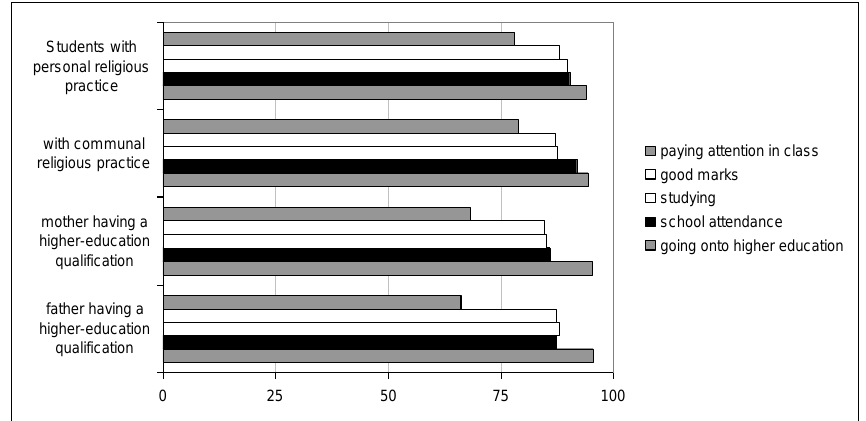
Figure 1. Proportion of those who consider studying-related activities important within their circle of